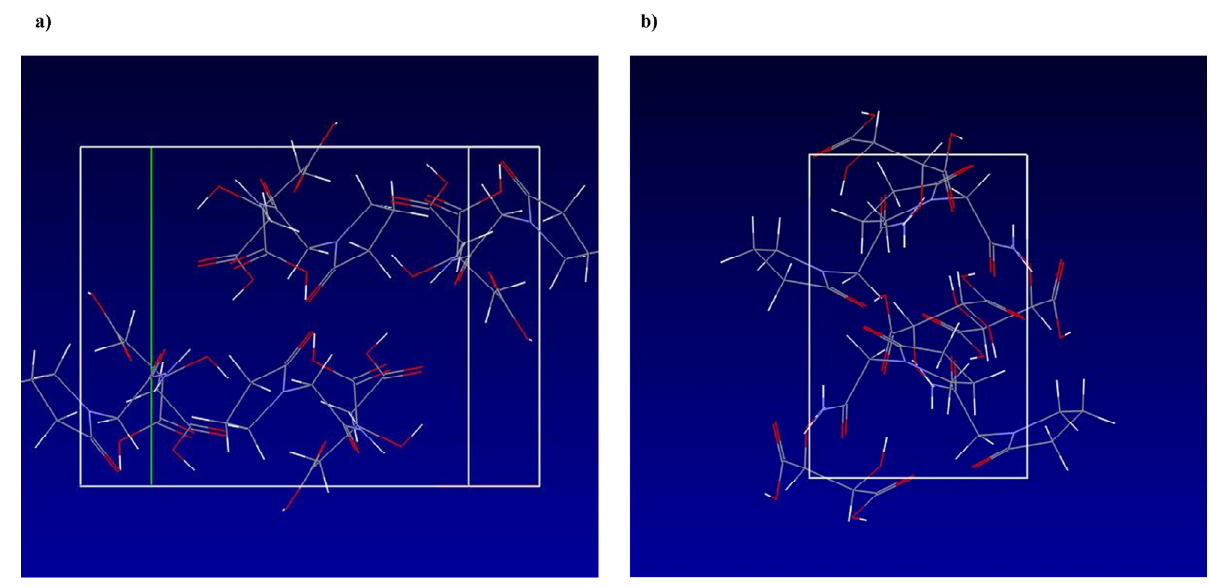
Figure 2. ( a ) 3D structure of the piracetam-citric acid unit cell. ( b ) 3D structure of the piracetam-tartaric acid unit cell (Cambridge Structural Database 2011)